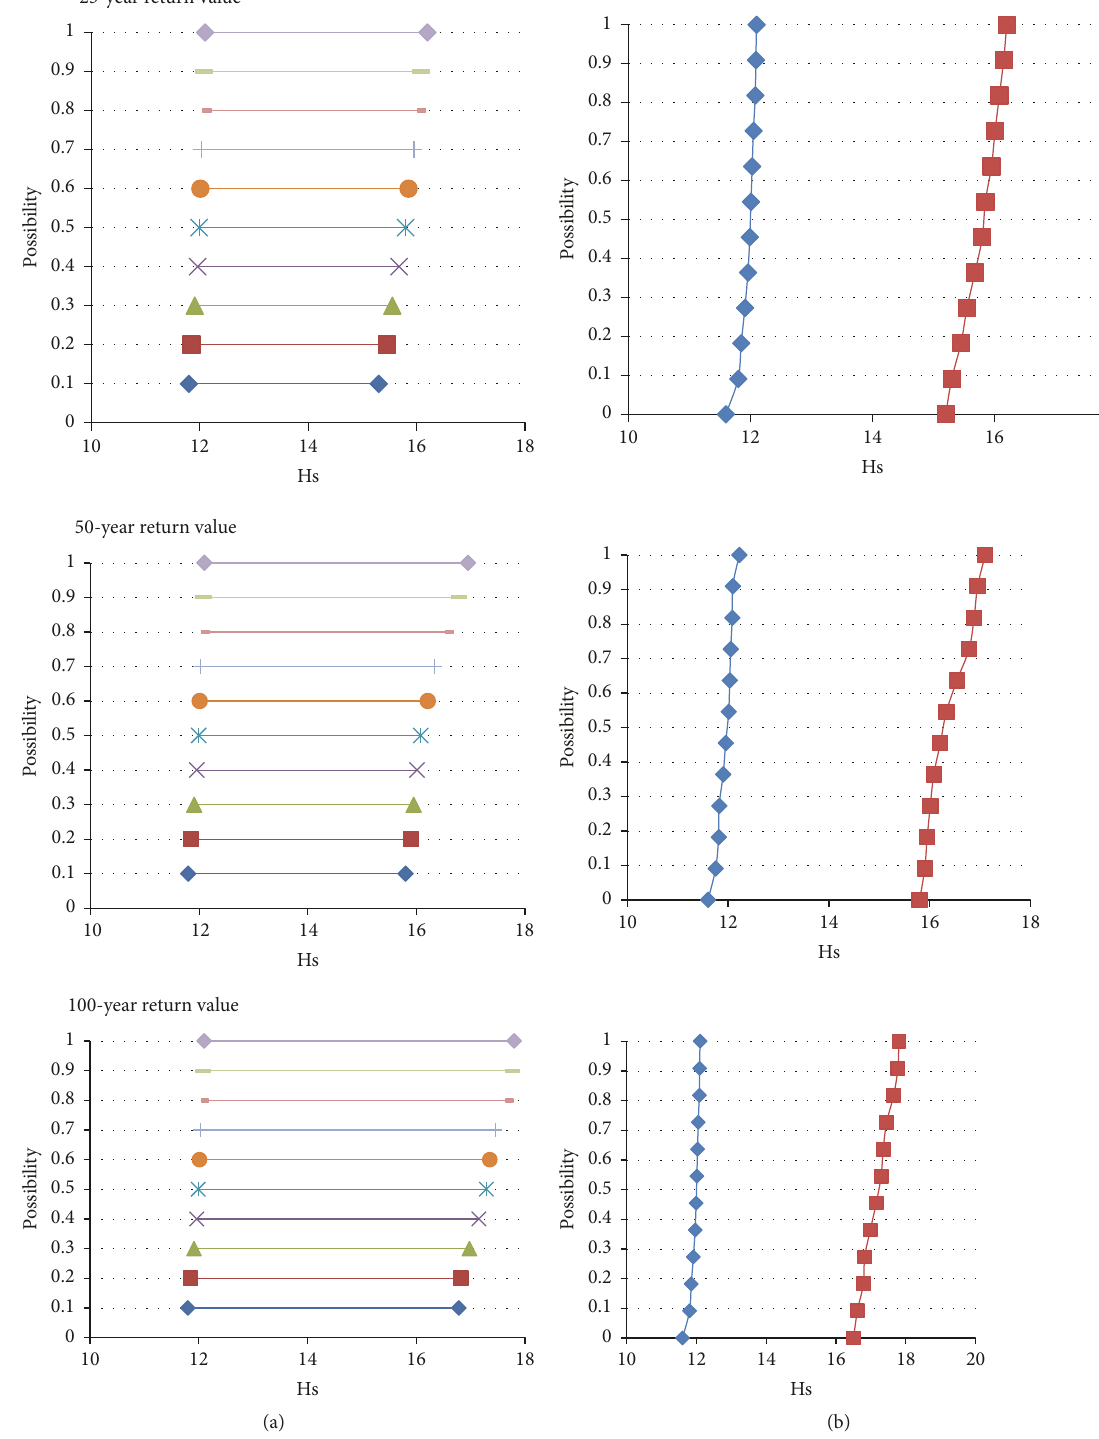
Figure 9: Lower and upper probabilities for 25, 50, and 100 year return value. (a) Observed original random sets. (b) The P-box